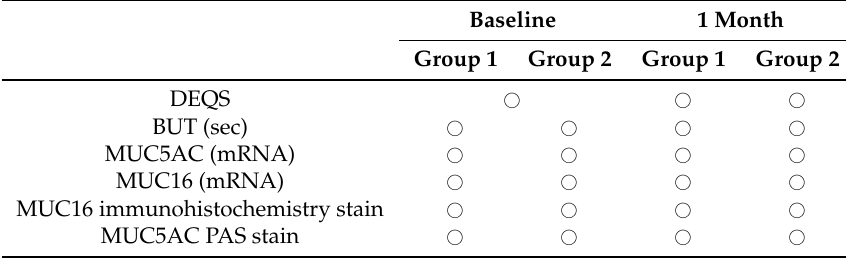
Table 1. Evaluation items at baseline and after 1 month of eyewash use.